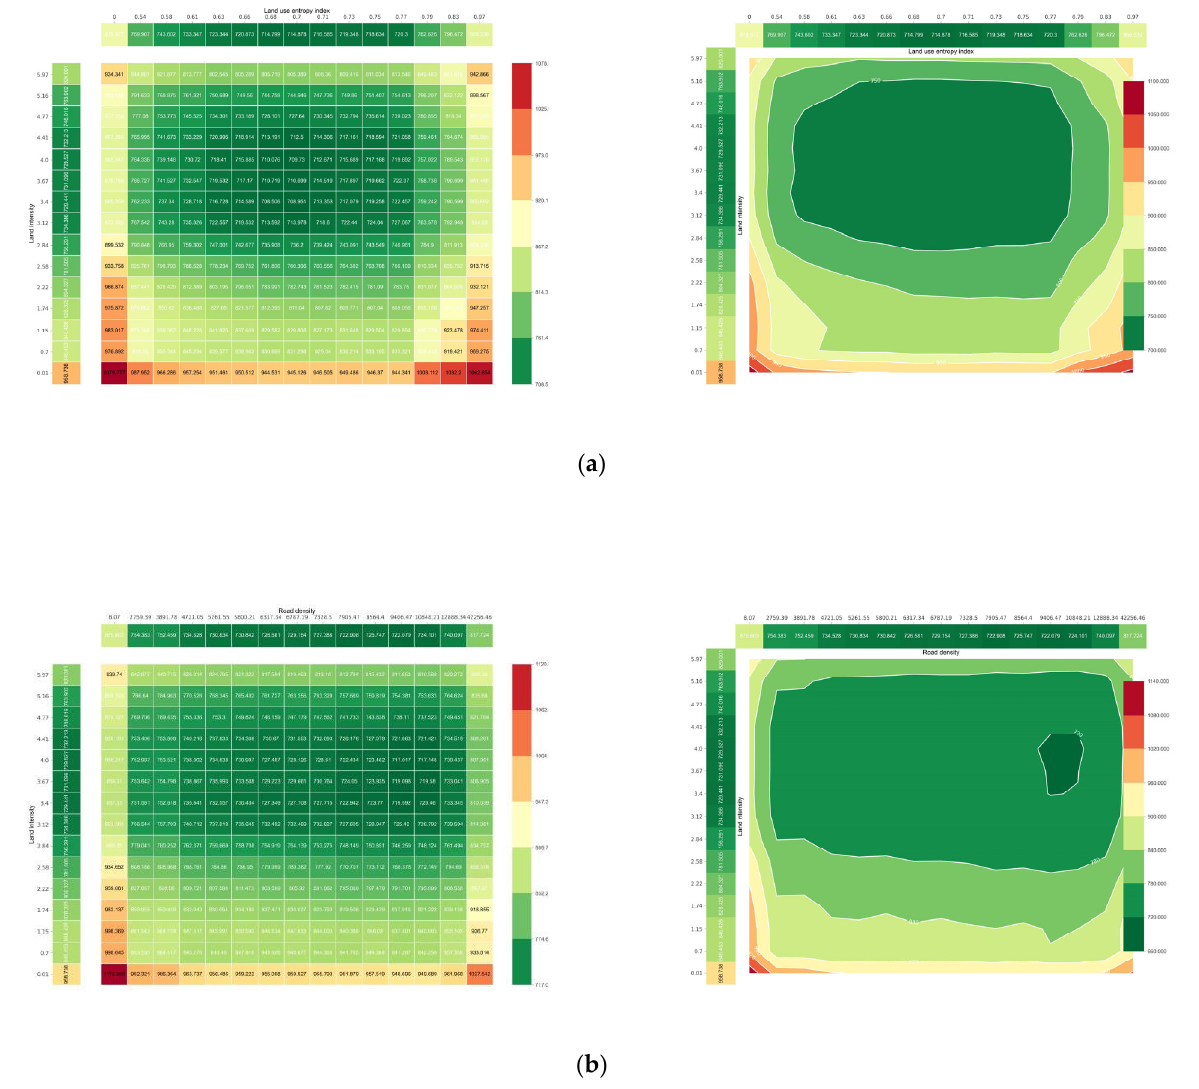
Int. J. Environ. Res. Public Health 2023 , 20 , x FOR PEER REVIEW